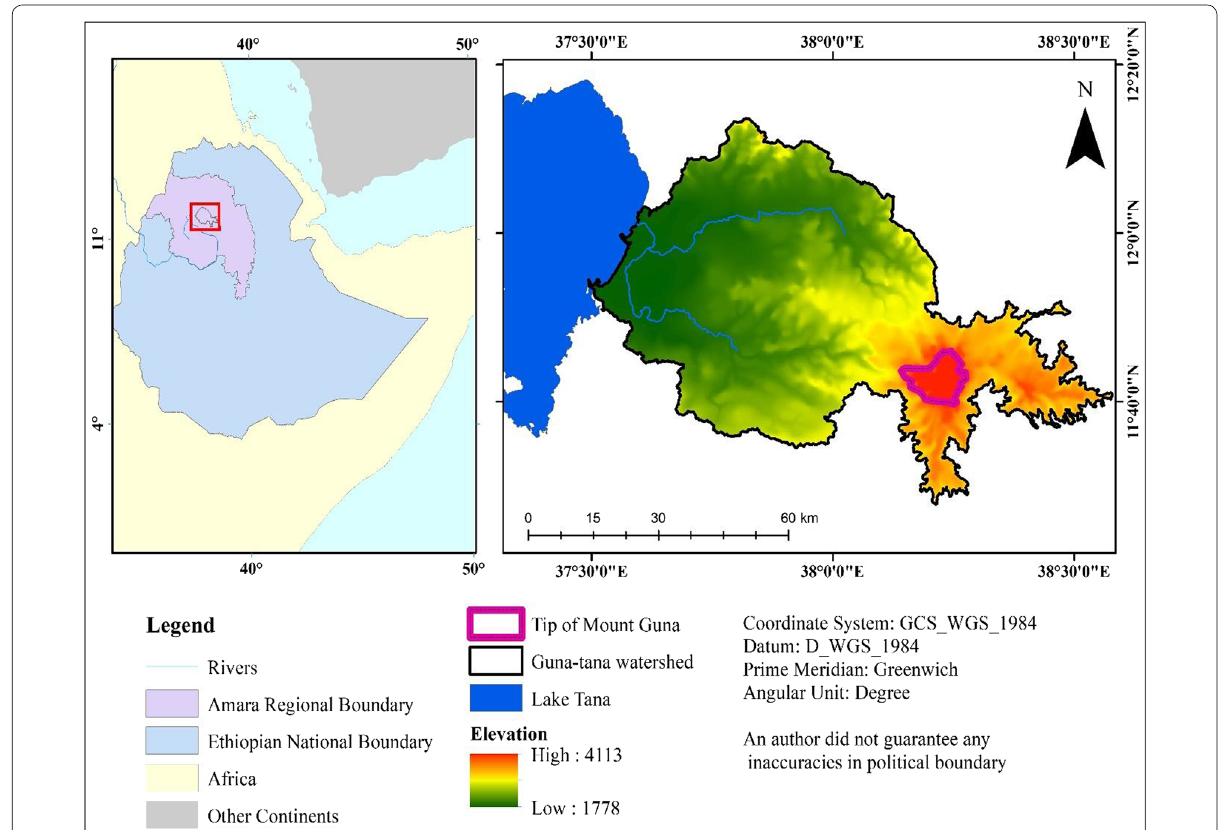
Fig. 1 Location map of the study